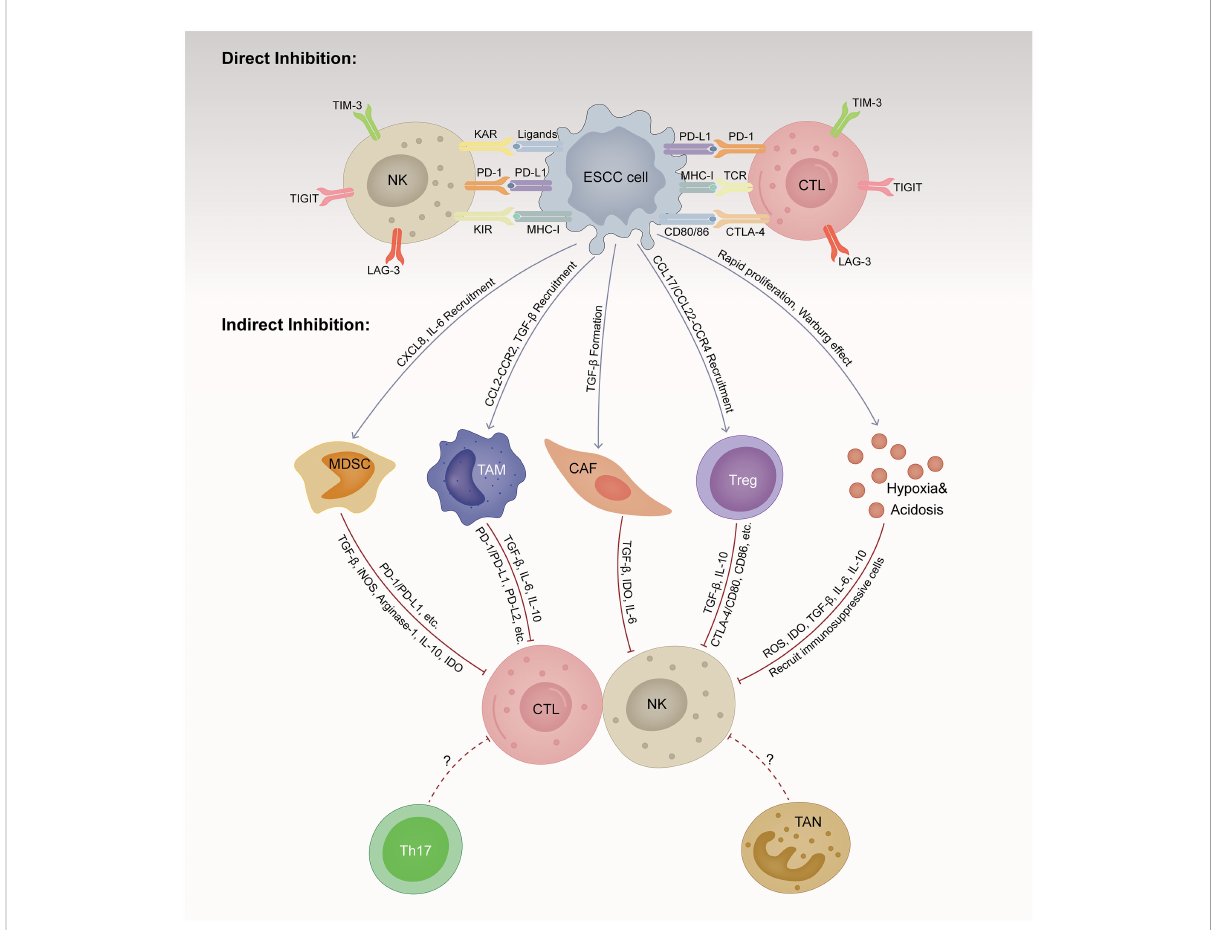
FIGURE 1 Immunosuppressive tumor microenvironment (TME) in esophageal squamous cell cancer (ESCC). TME is a dynamic complex and comprehensive system, composed of various cellular components and non-cellular components. ESCC cells are born to create an immunosuppressive milieu suppressing the proliferation and function of cytolytic NK and T cells directly and indirectly. ESCC, esophageal squamous cell cancer; CTL, cytotoxic T lymphocyte; NK, natural killer cell; MDSC, myeloid-derived suppressor cell; TAM, tumor-associated macrophage; CAF, cancer-associated fi broblast; Treg, regulator T cell; TAN, tumor-associated neutrophils; Th17, T helper cell 17; MHC-1, major histocompatibility class I; TCR, T cell receptor; KAR, killer activation receptor; KIR, killer inhibitory receptor; PD-1, programmed cell death protein 1; PD-L1, programmed cell death ligand 1; PD-L2, programmed cell death ligand 2; CTLA-4, cytotoxic T lymphocyte-associated antigen 4; LAG-3, lymphocyte activation gene-3; TIM-3, T-cell immunoglobulin and mucin domain-containing protein-3; TIGIT, T-cell immunoglobulin and immunoreceptor tyrosine-based inhibitory motif domain; TGF- b , transforming growth factor- b ; IL, interleukin; CXCL, CXC motif chemokine ligand; CCL, CC motif chemokine ligand; CCR, CC motif chemokine receptor; IDO, indoleamine 2,3-dioxygenase; iNOS, inducible nitric oxide synthase-2; ROS, reactive oxygen